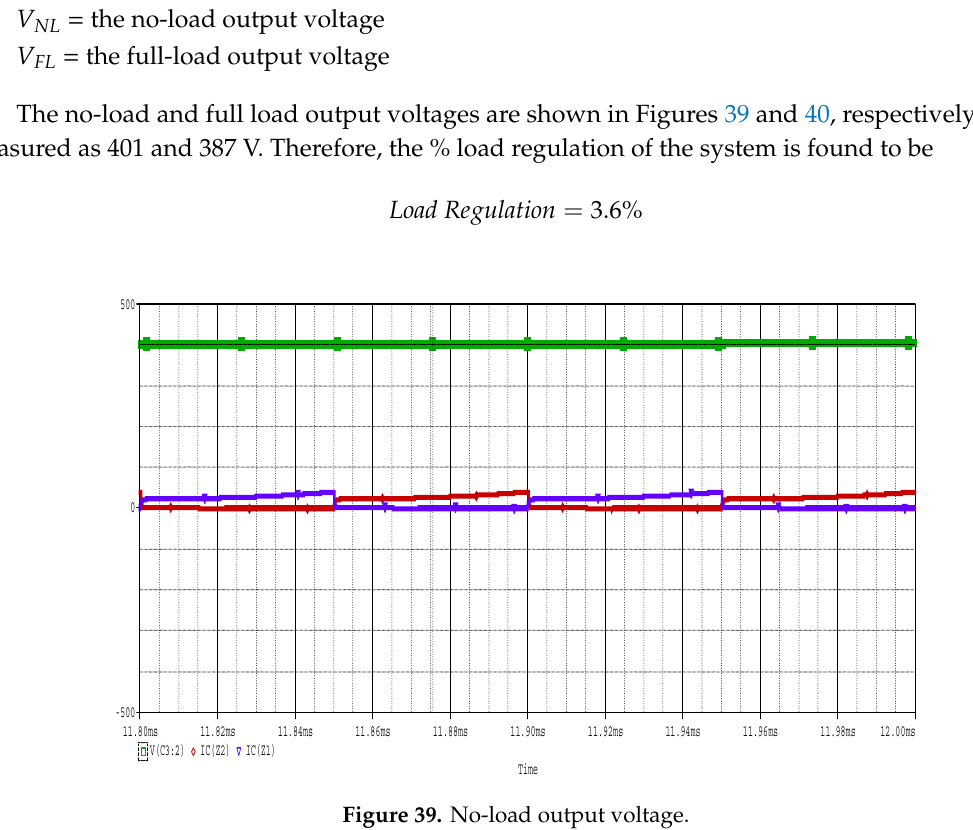
Figure 38. Switching stress comparison.